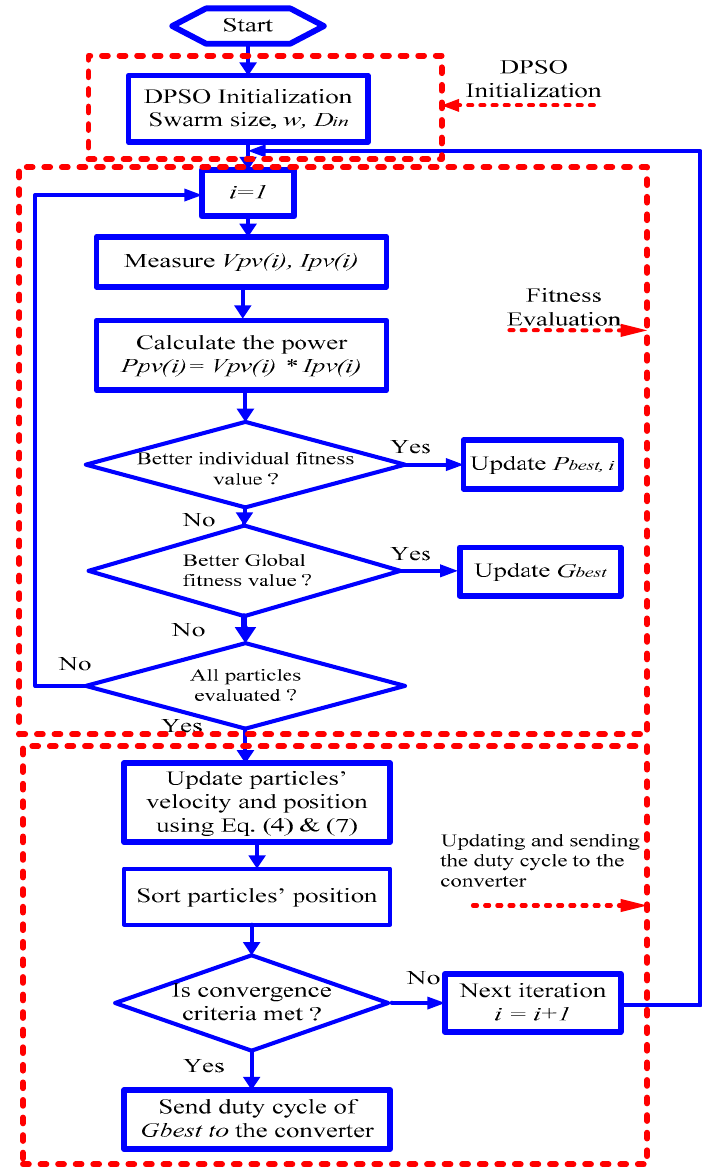
Figure 5. The Flowchart of deterministic particle swarm optimization (DPSO) based maximum power point tracker (MPPT).